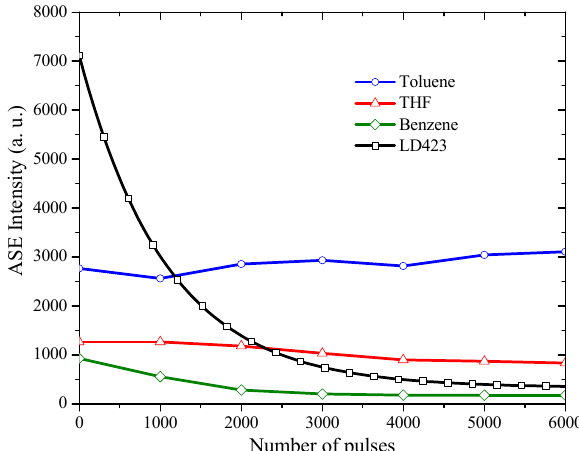
Figure 9. The stability of the ASE intensity versus the number of pulses for PFO-co-pX in different solvents at a concentration of 60 μ M and a pump energy of 6 mJ; 0.22 M LD423 and a 6 mJ pump laser.